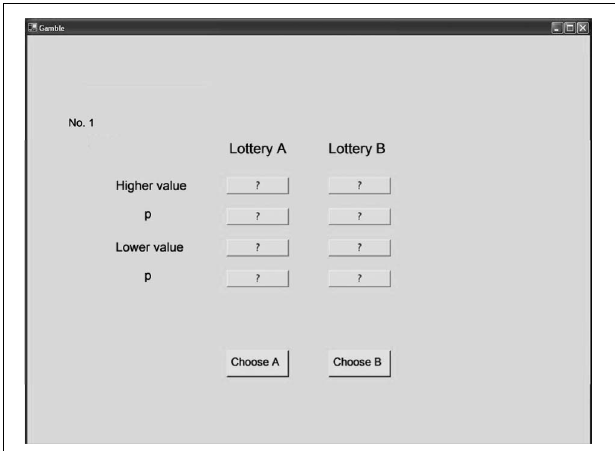
FIGURE 2 | Screenshot of the Mouselab program used in the